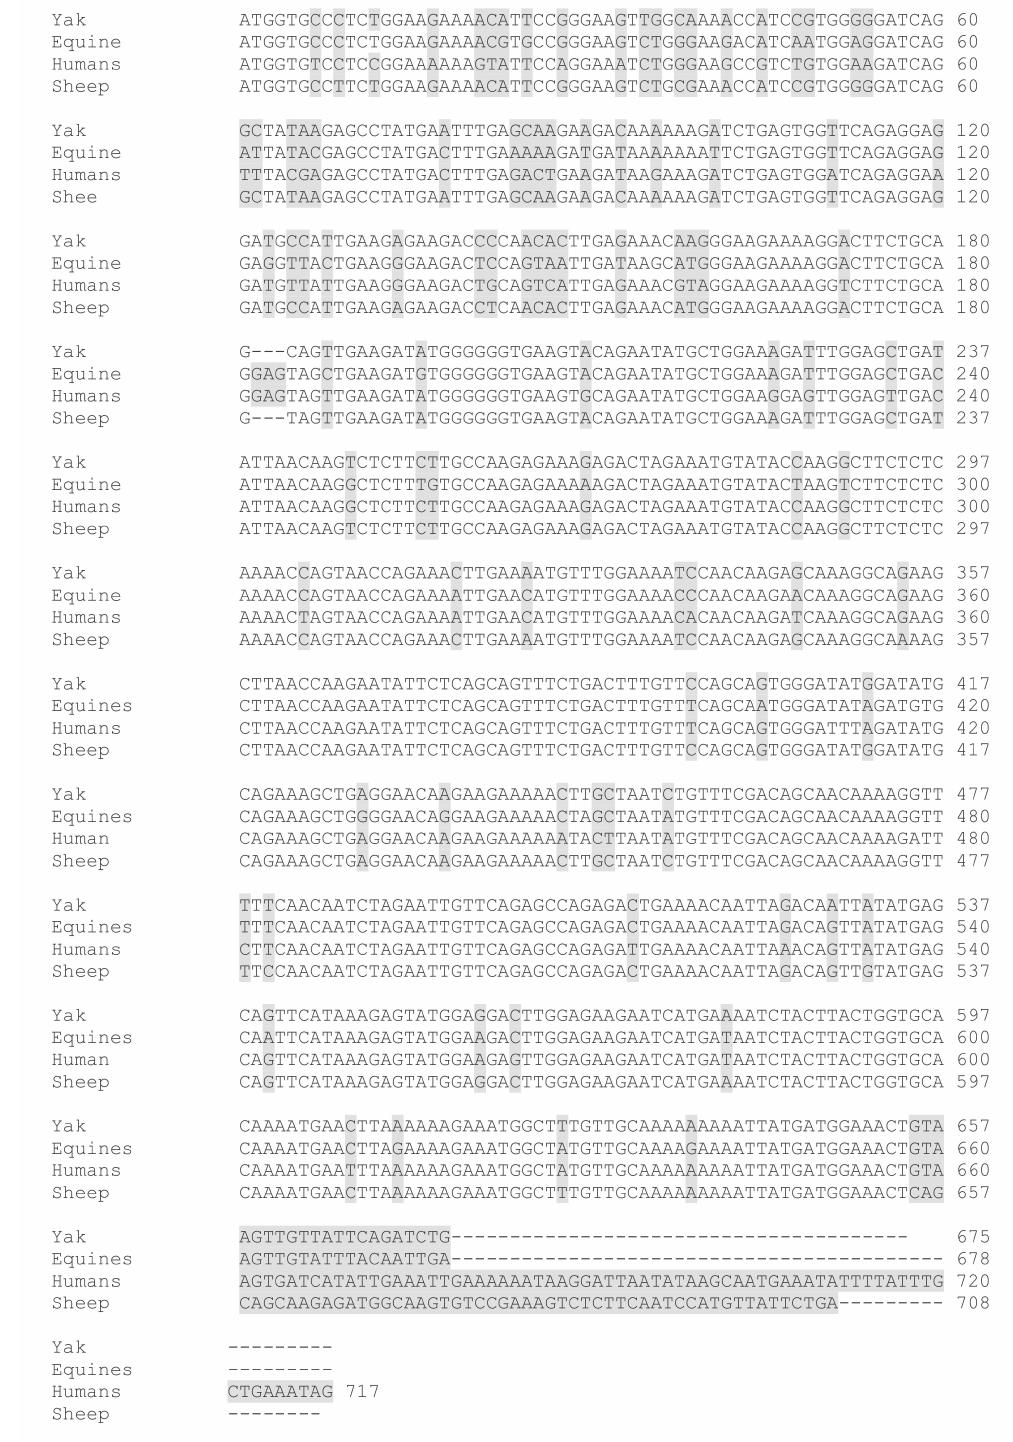
Figure 6. Multiple alignment of full-length sequences of yak SYCP3 protein with equines, humans, and sheep. Dissimilar amino-acids are represented by shaded